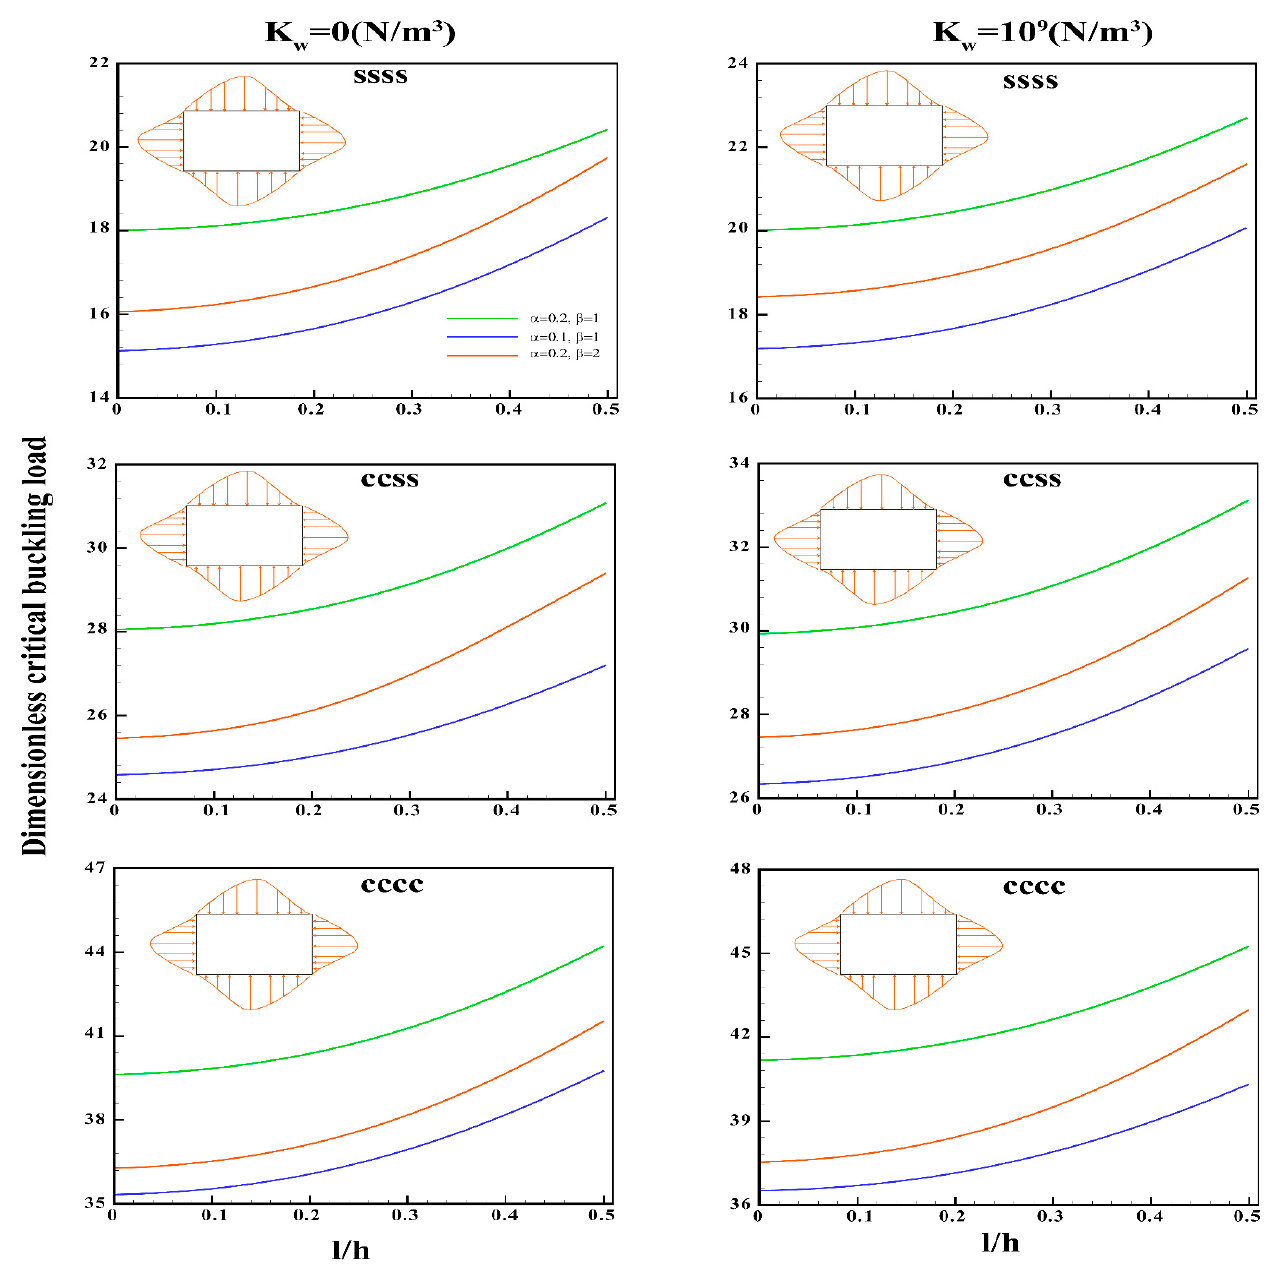
Figure 4. Variations of the dimensionless biaxial buckling load of the UD-CNTRC microplate against the material length scale parameter to thickness ratio for different boundary conditions and different values of the elastic medium stiffness parameter (sinusoidal edge compressive load).